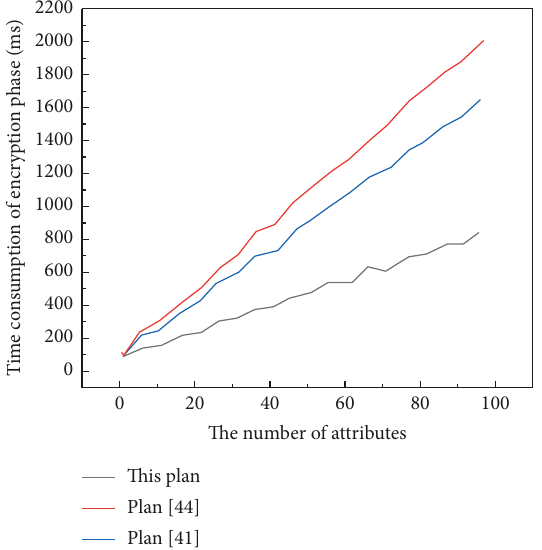
Figure 4: Time consumption of encryption